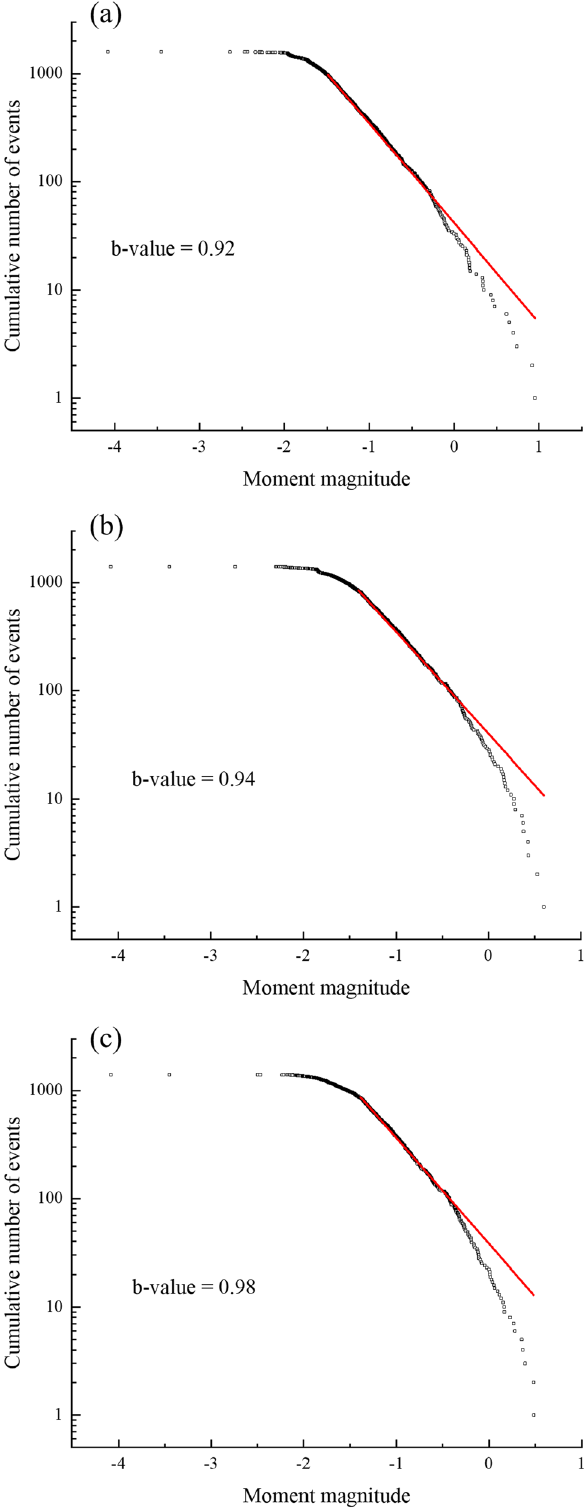
Fig. 15 b -values for different thresholds of stress drop to define a seismic event: a 0.2 MPa b 0.3 MPa c 0.4